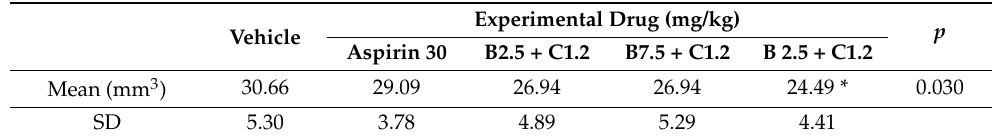
Table 6. Effects of Sample B + C on infarct volume after pMCAO ( n = 8–10 mice for each group, vehicle for n = 19).